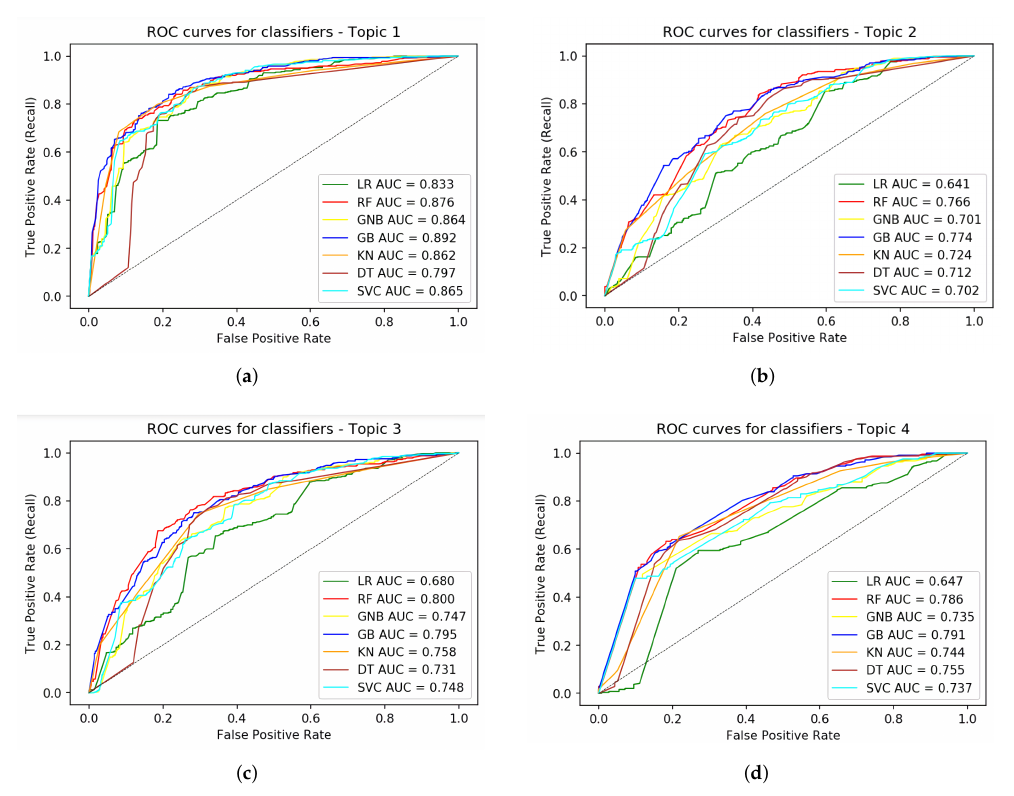
Figure 6. ROC curves of different classifiers for the data sets related to the dominant topics. SVC is the function in Scikit-learn, to implement SVM. ( a ) Topic 1. ( b ) Topic 2. ( c ) Topic 3. ( d ) Topic